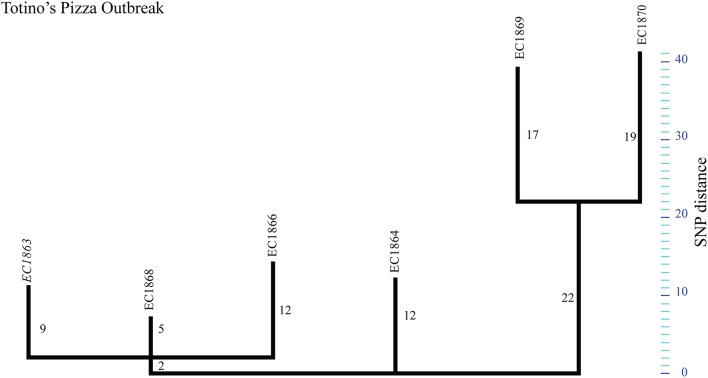
Phylogenetic tree for Totino's Pizza outbreak strains. Maximum parsimony phylogeny of the Totino's Pizza outbreak using reference EC1863. The tree topology shows the genotypic heterogeneity among the outbreak associated strains, forming “two” distinct phylogenetic groups.